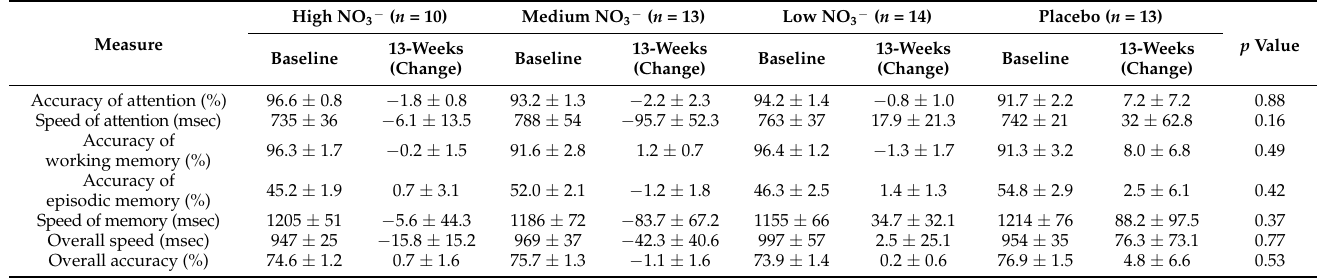
Table 3. Mean values for baseline and for change from baseline after 13 weeks of intervention on global cognitive measures for different doses of